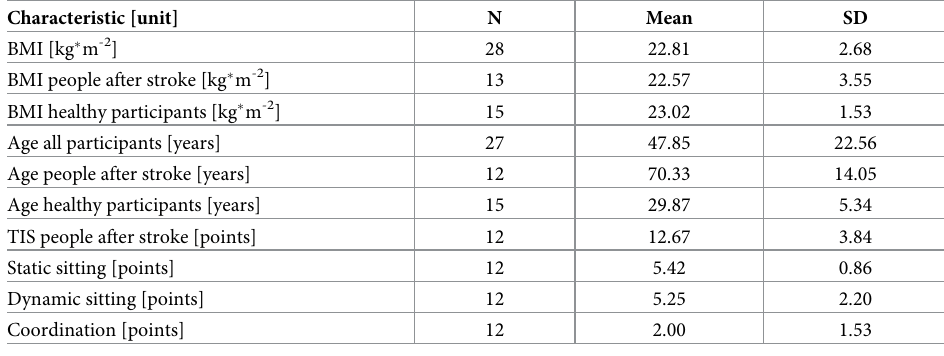
Table 2. Means and standard deviations of participant